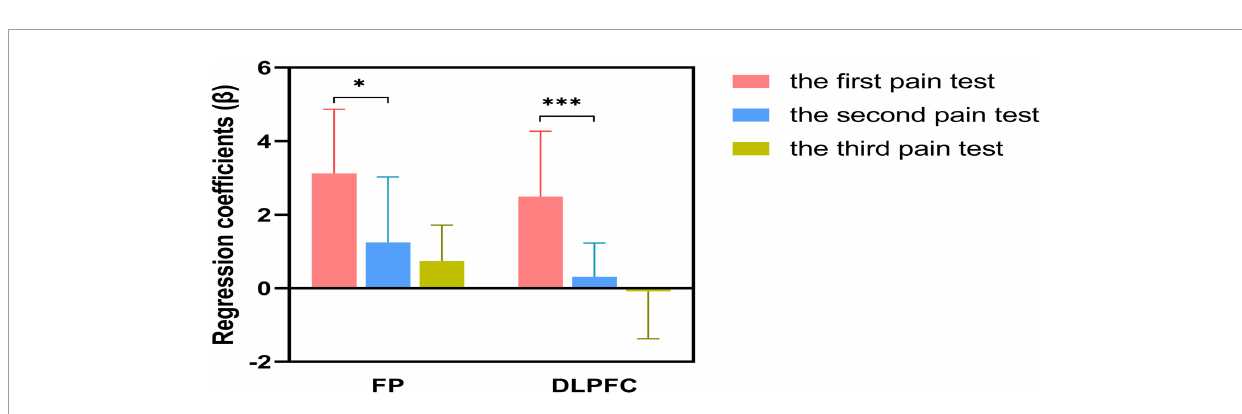
FIGURE7 The β values of the regions of interest (ROI) were extracted from the results of the three pain tests. * P < 0.05, *** P <